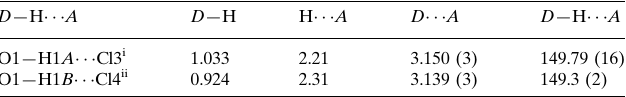
Hydrogen-bond geometry (A˚ , (cid:4)